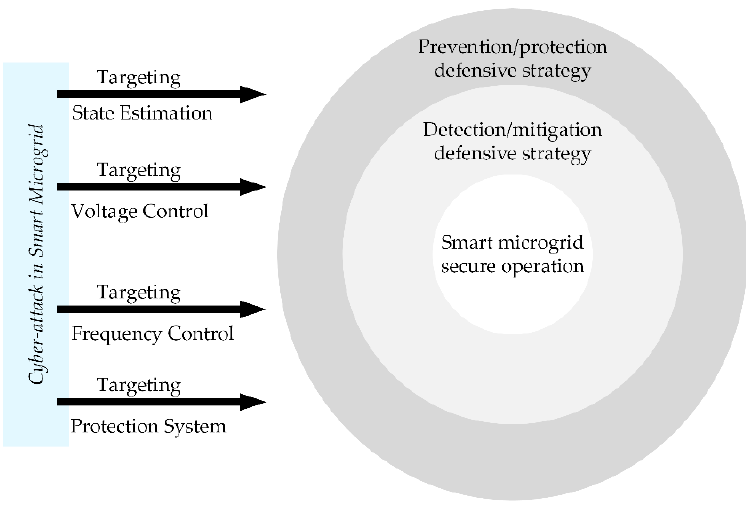
Figure 3. Cyber-attacks in smart microgrids and defensive lines.